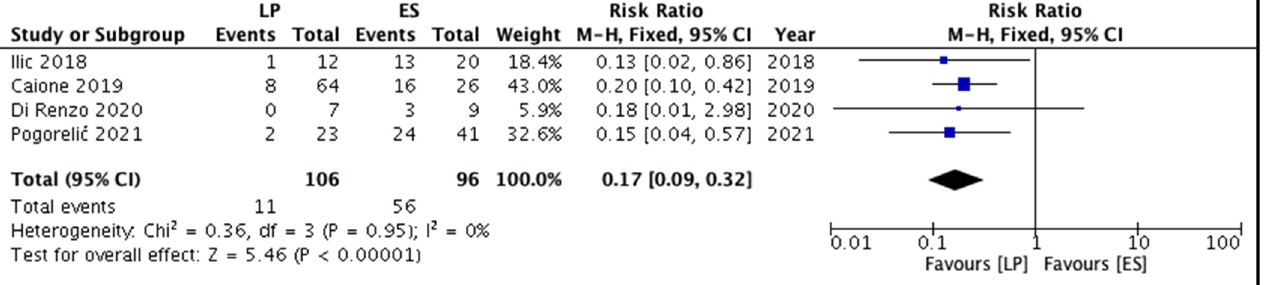
Figure 2. Forest plot comparison between the two patient groups in terms of the incidence of de novo vesicoureteral reflux. Legends: LP, laser puncture patient group. ES, electrosurgical incision patient group. M-H, Mantel-Haenszel method. CI, confidence interval.